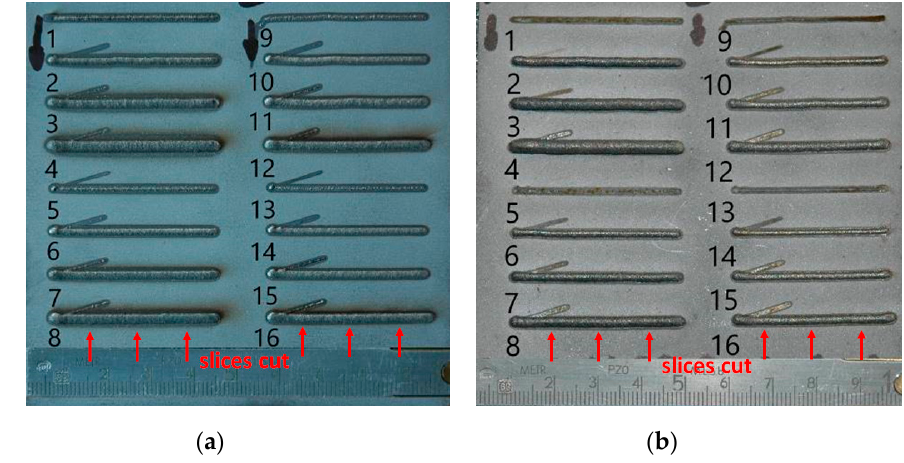
Figure 3. A view of stringer beads produced by the laser deposition of experimental Fe-based metallic powder at ( a ) free cooling conditions (conventional laser cladding); ( b ) and forced cooling by liquid nitrogen bath under cryogenic conditions (hybrid laser deposition process), as shown in Table 3.